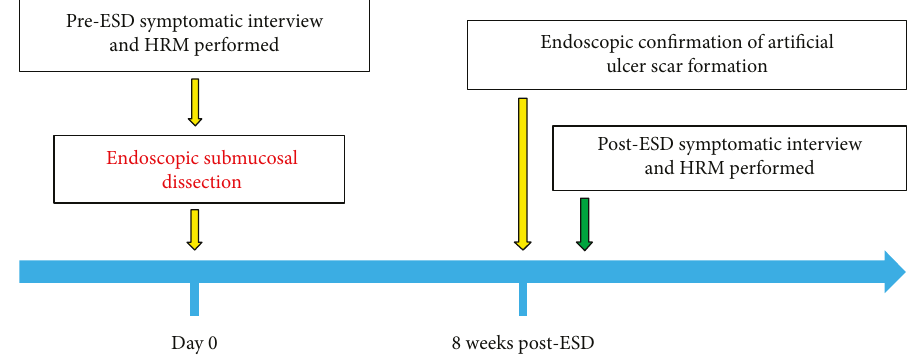
Figure 2: Schedule of symptom scoring, high-resolution manometry (HRM), and endoscopic submucosal dissection (ESD). The patients were interviewed to determine the symptom scores (dysphagia score and Eckardt score) and HRM was performed before ESD. Eight weeks after ESD, the arti fi cial ulcer scar was con fi rmed endoscopically; the interview to determine the symptom scores and HRM were performed on a separate date to avoid any in fl uence from air insu ffl ation and insertion of the